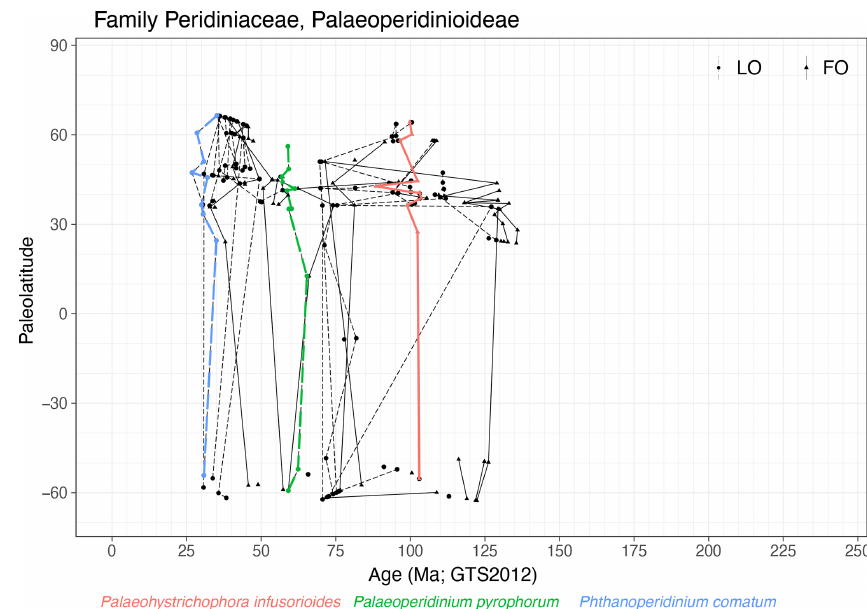
Figure 22. Same as Fig. 5 but for the family Peridiniaceae, subfamily Palaeoperidinioideae.